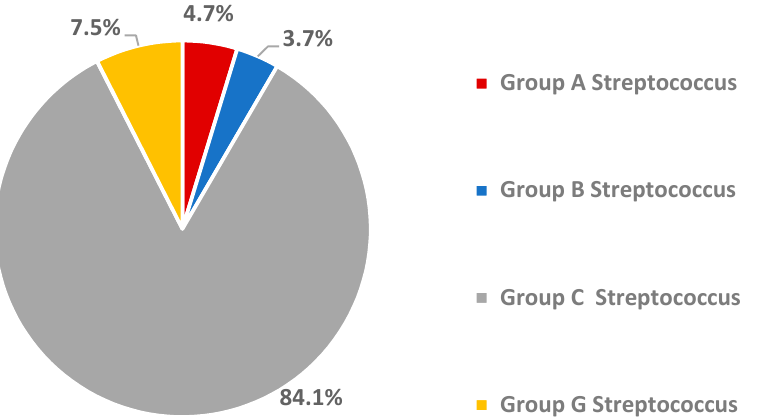
Figure 1. Serogroup distribution among 107 beta-haemolytic streptococci detected in oropharyngeal swabs of healthy children in Bouaké, central Côte d’Ivoire in March 2017.